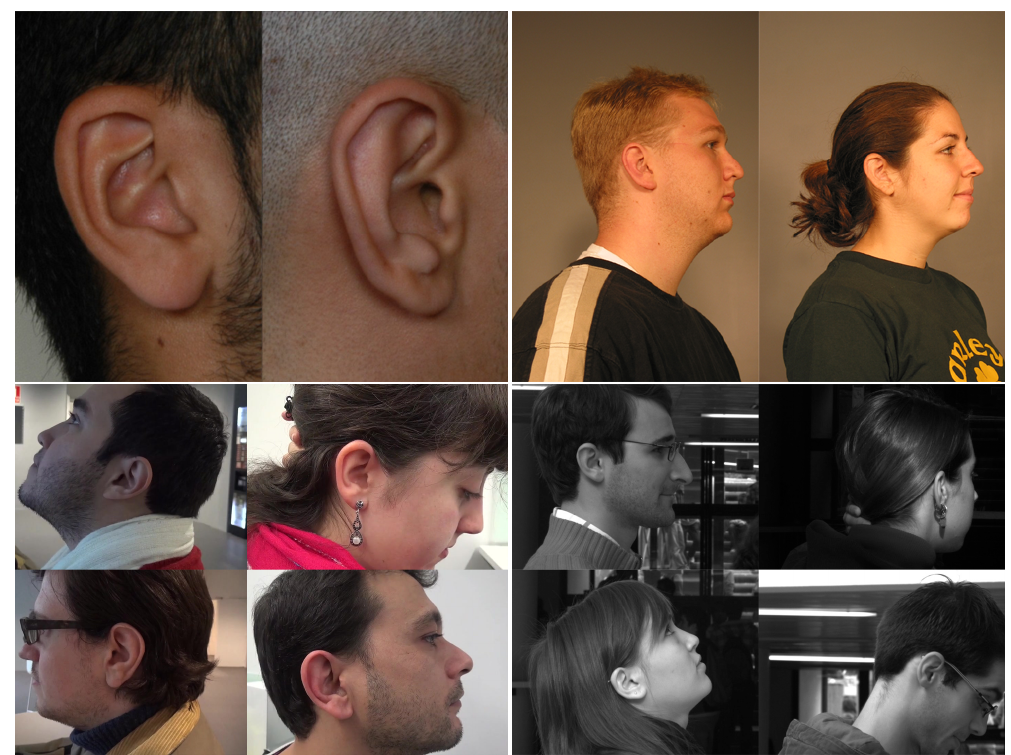
Figure 1. Samples from each of the four datasets used in this work: ( Top Left ) AMI Dataset, ( Top Right ) UND Dataset, ( Bottom Left ) Videos Dataset, ( Bottom Right ) UBEAR